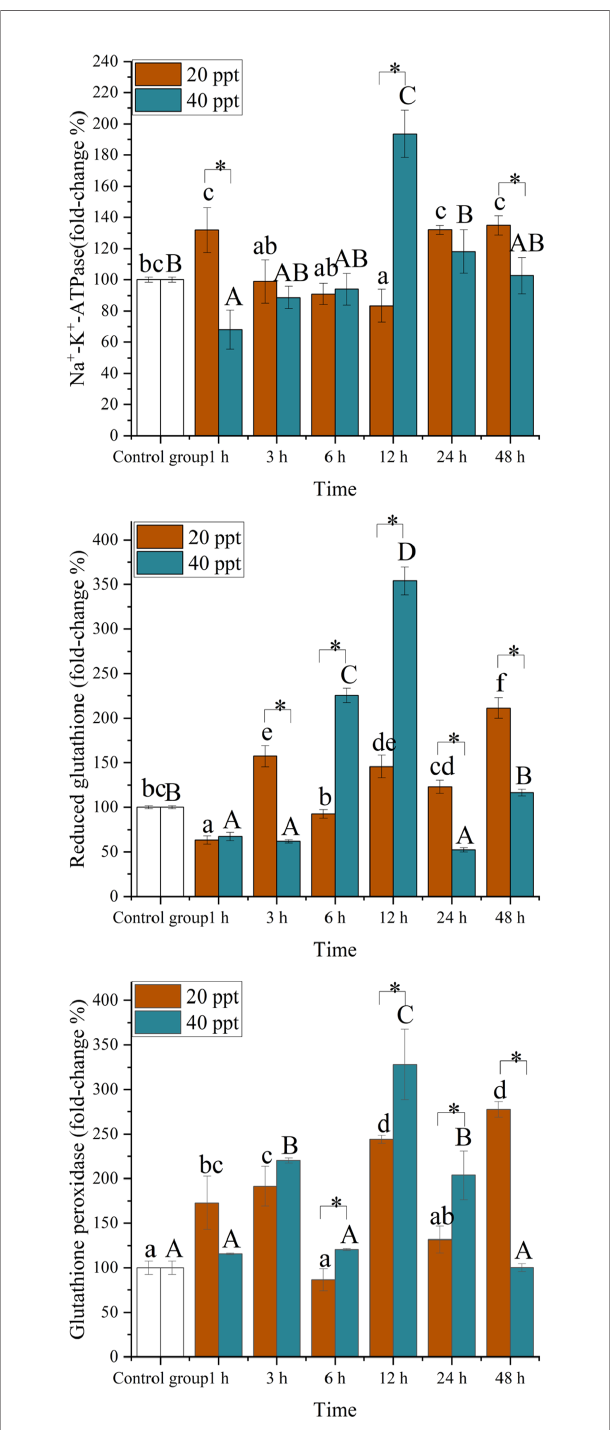
FIGURE 1 | Effect of acute salinity stress on Na + -K + -ATPase, reduced glutathione, and glutathione peroxidase of Pinctada maxima. Data were expressed as mean ± SD (n = 3). Different lowercase letters (a – e) in the fi gure show signi fi cant differences ( P < 0.05) among the salinity 20 ppt group, different capital letters (A – D) in the fi gure show signi fi cant differences ( P < 0.05) among the salinity 40 ppt group, and * shows signi fi cant differences ( P < 0.05) among treatment